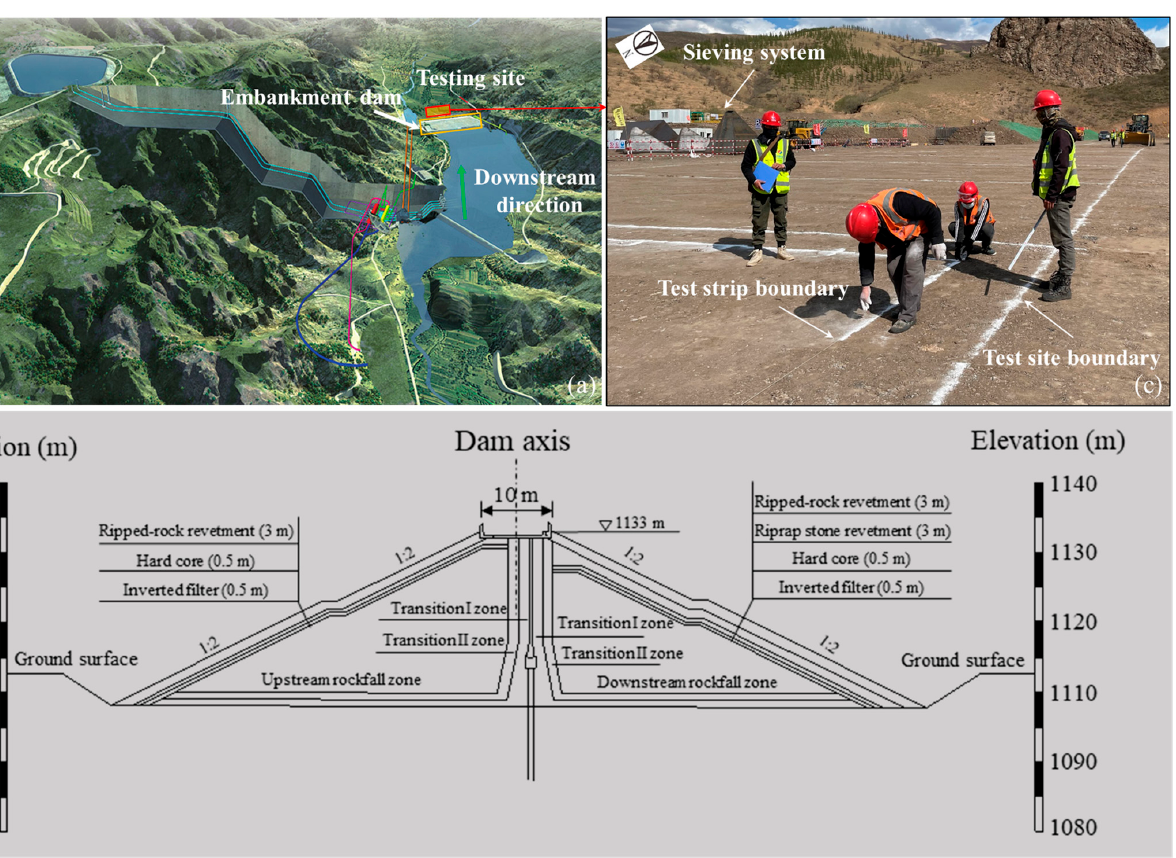
Figure 3. Testing site in Zhirui hydropower station: ( a ) Panorama of Zhirui hydropower station; ( b ) Cross section of the embankment dam; and ( c ) Photo of the testing site.